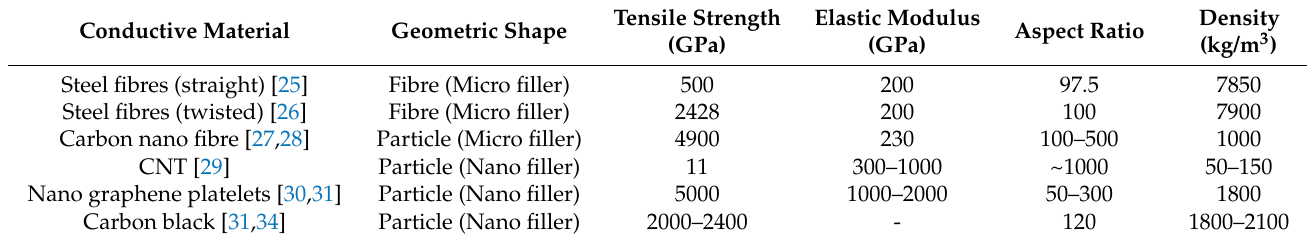
Table 3. Types of fillers used in self-sensing and their